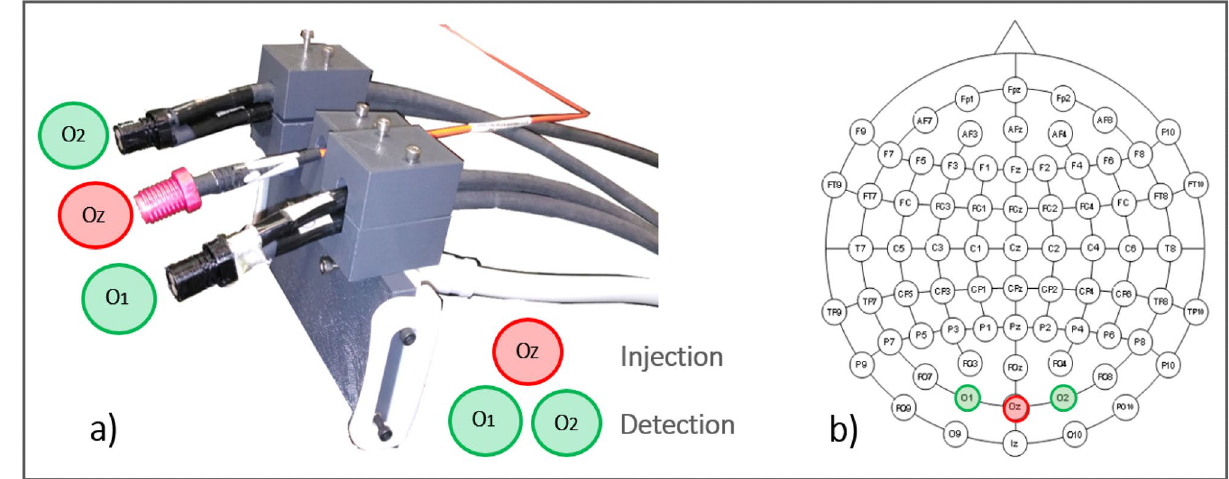
Figure 4. ( a ) Optical probe picture. ( b ) Optodes positioning on the occipital region according to the 10–10 EEG system 17 . Oz: injection optode. O1 and O2: detection